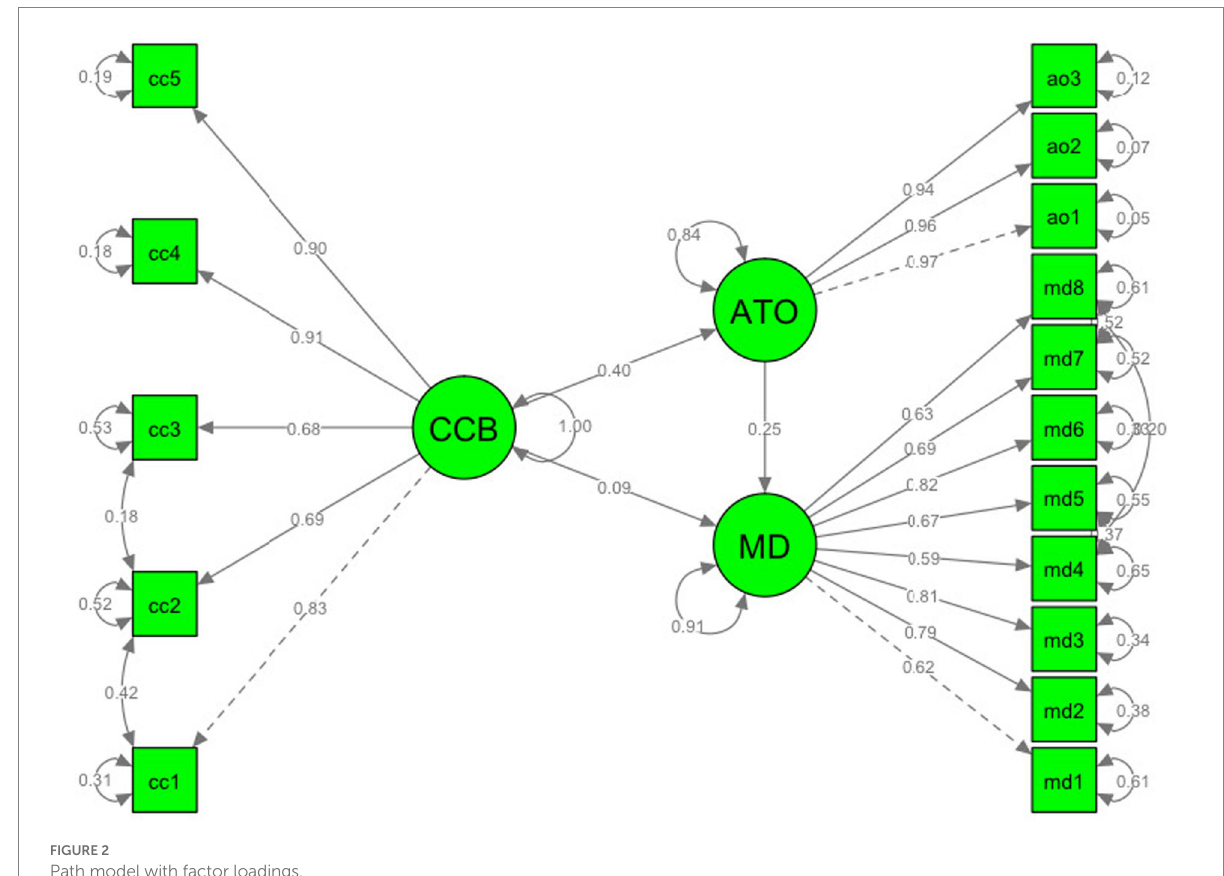
FIGURE 2 Path model with factor loadings.